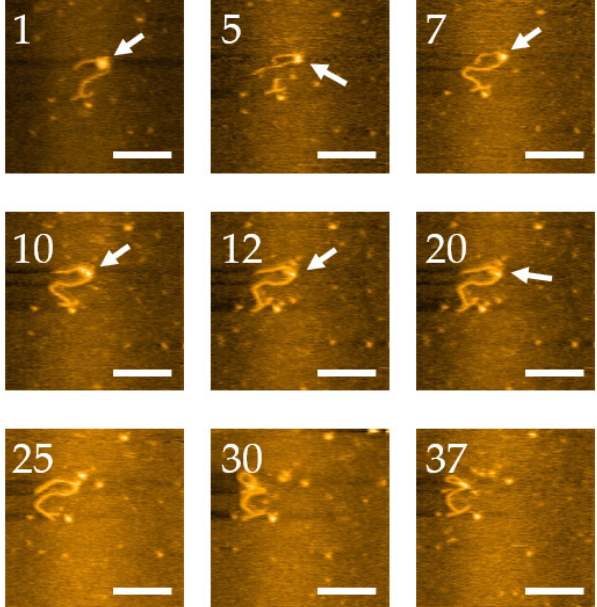
Figure 8. High-speed AFM imaging of nucleosome dynamics on labeled DNA. The nucleosome is indicated with arrows. Scale bars indicate 50 nm. The numbers in each image are their frame number in the movie. The numbers in each image are their frame number in the movie. The complete set of frames can be visualized in Movie S2.